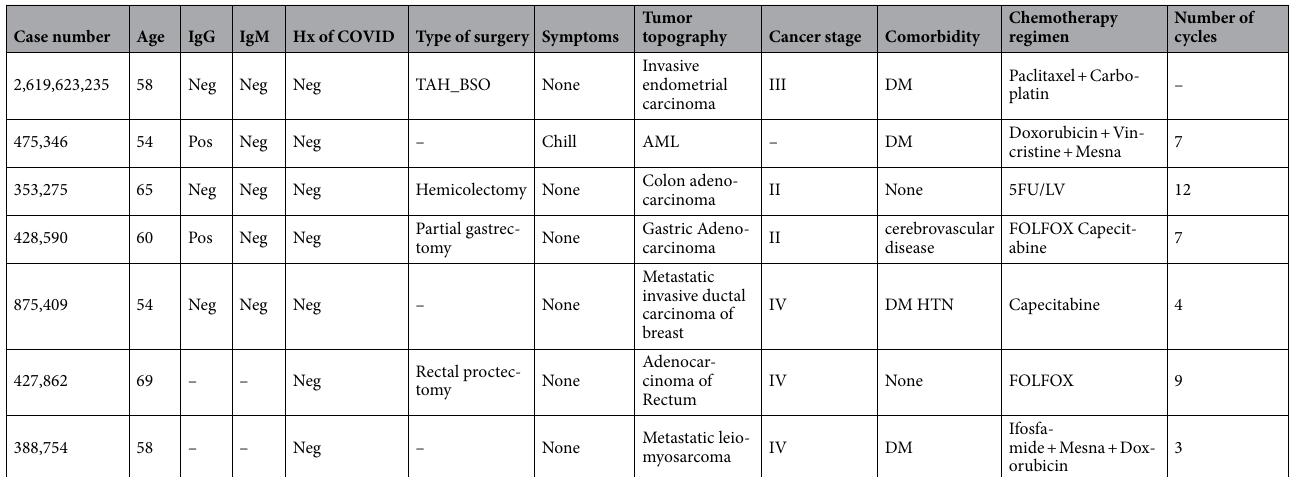
Table 2. Clinical characteristics of COVID-19 infected cancer patients according to the RT-PCR